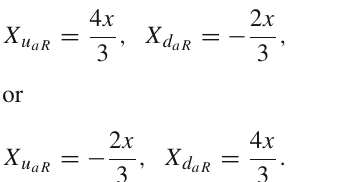
Table 3 The ratio between BR of the top quark and BR of all quarks χ ψ η LR U ( 1 ) BR top BR